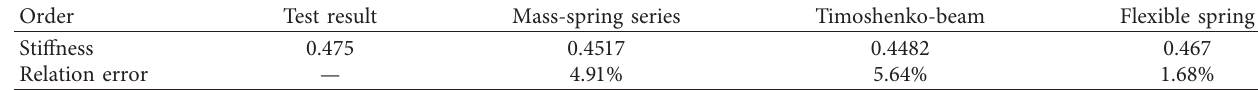
Table 5: Comparison of the static stiffness.